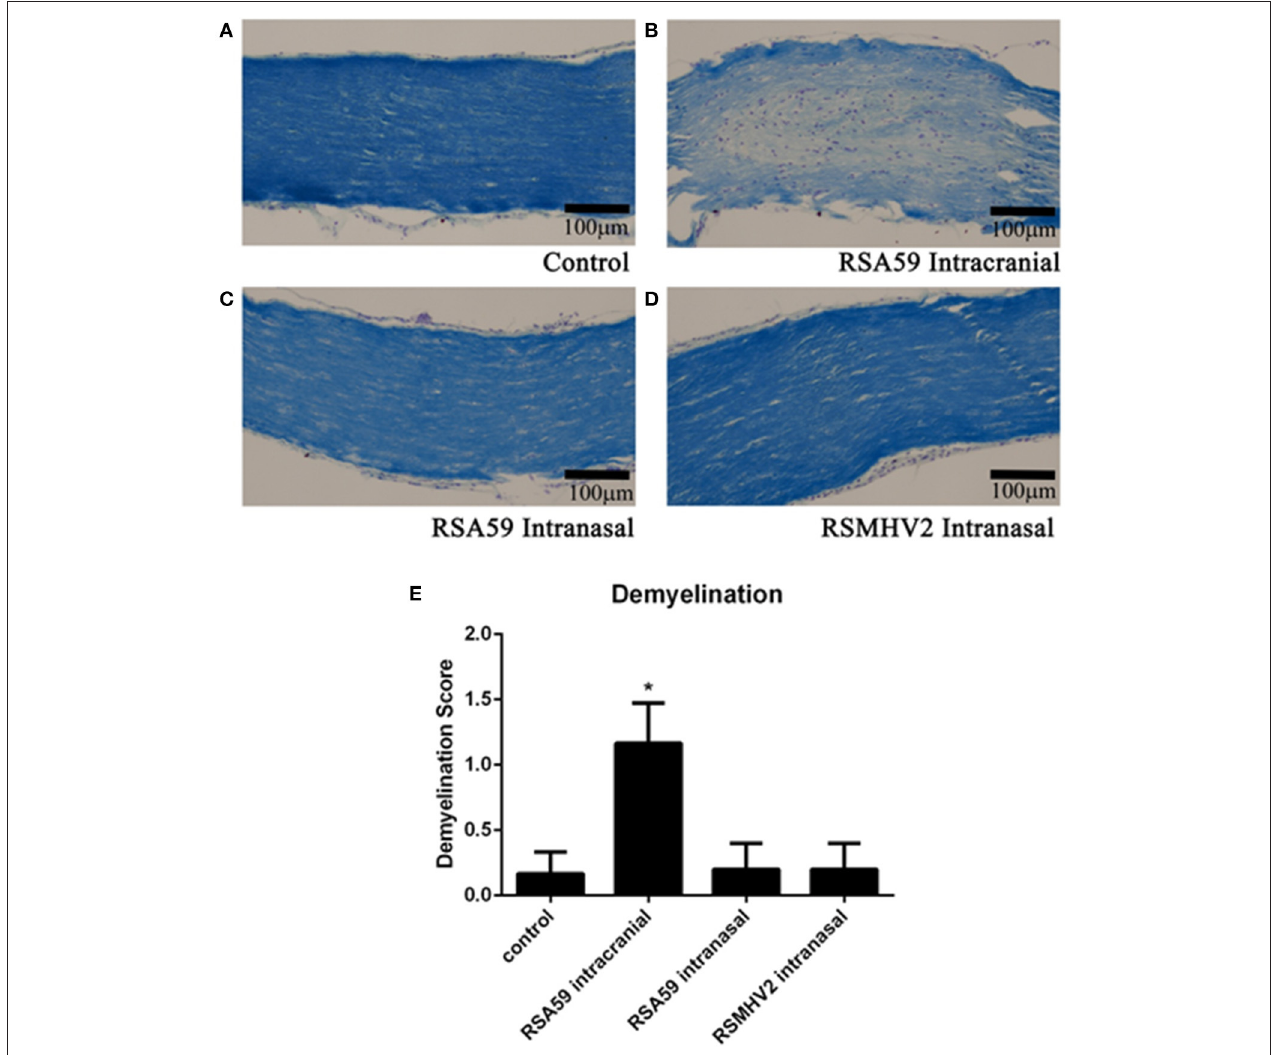
FIGURE 2 | Comparative optic nerve demyelination study between intracranially-and intranasally-infected mice. Representative optic nerve sections from chronic stage (day 26 p.i.) mock-infected ( n = 6) (A) , RSA59 intrancranially-infected ( n = 6) (B) , RSA59 intranasally-infected ( n = 5) (C) , and RSMHV2 intranasally-infected ( n = 5) (D) mice stained with LFB show demyelination only in RSA59 intracranially-infected mice (scale bar = 100 µ m). The relative level of demyelination scored by a blinded investigator showed significant demyelination in optic nerves of mice inoculated intracranially with RSA59, but not in mock-infected (control) mice nor in mice infected intranasally with either RSA59 or RSMHV2 (* p < 0.05 vs. all other groups) (E) . Data comparisons were done by one-way ANOVA and Tukey’s Multiple Comparison post-hoc testing with GraphPad Prism 6.0